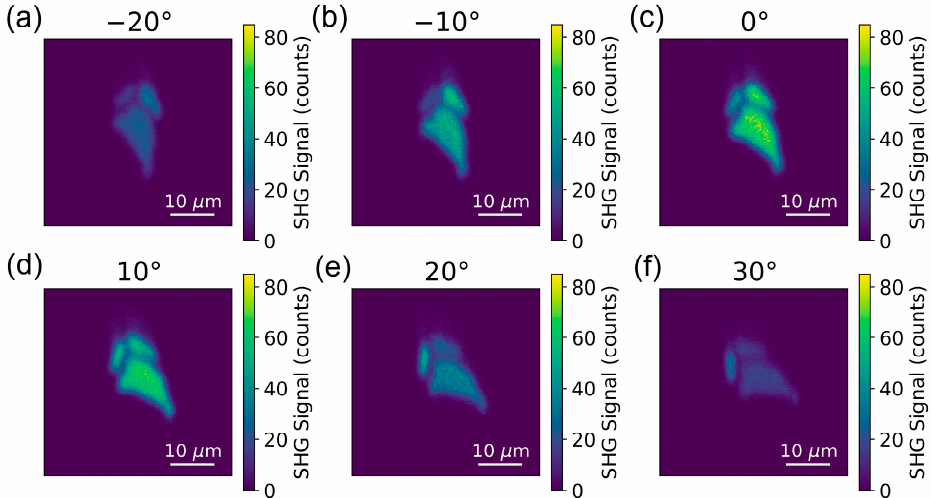
Figure 1. Images of SHG with polarization parallel to the incident light polarization for rotational angles ( a – f ) from −20° to 30° .